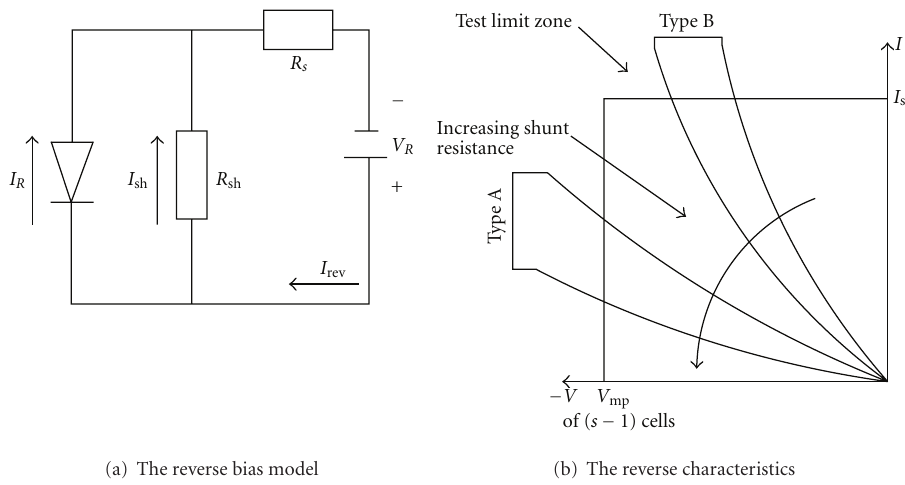
Figure 1: The reverse bias model and the reverse characteristic of crystalline silicon solar cells.